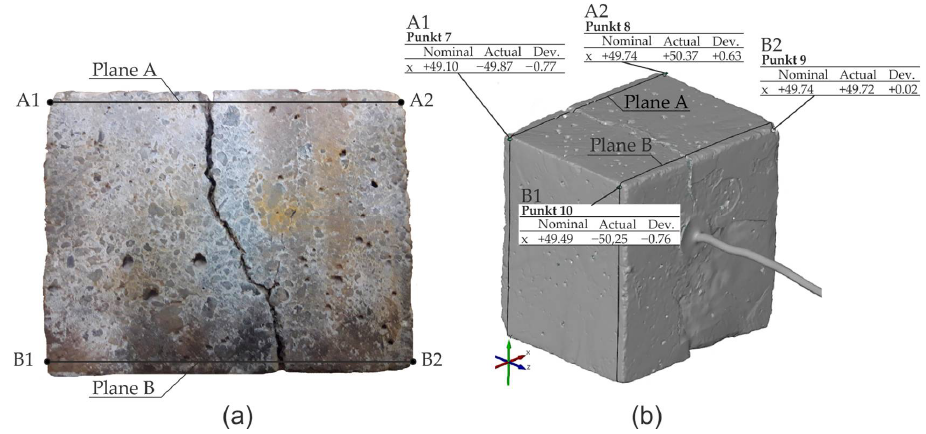
Figure 7. Measurements of crack opening during experimental tests: ( a ) schematic of the location of planes and control points, ( b ) reading of the displacement of points in the program GOM Inspect for the testing period t = 388 h.